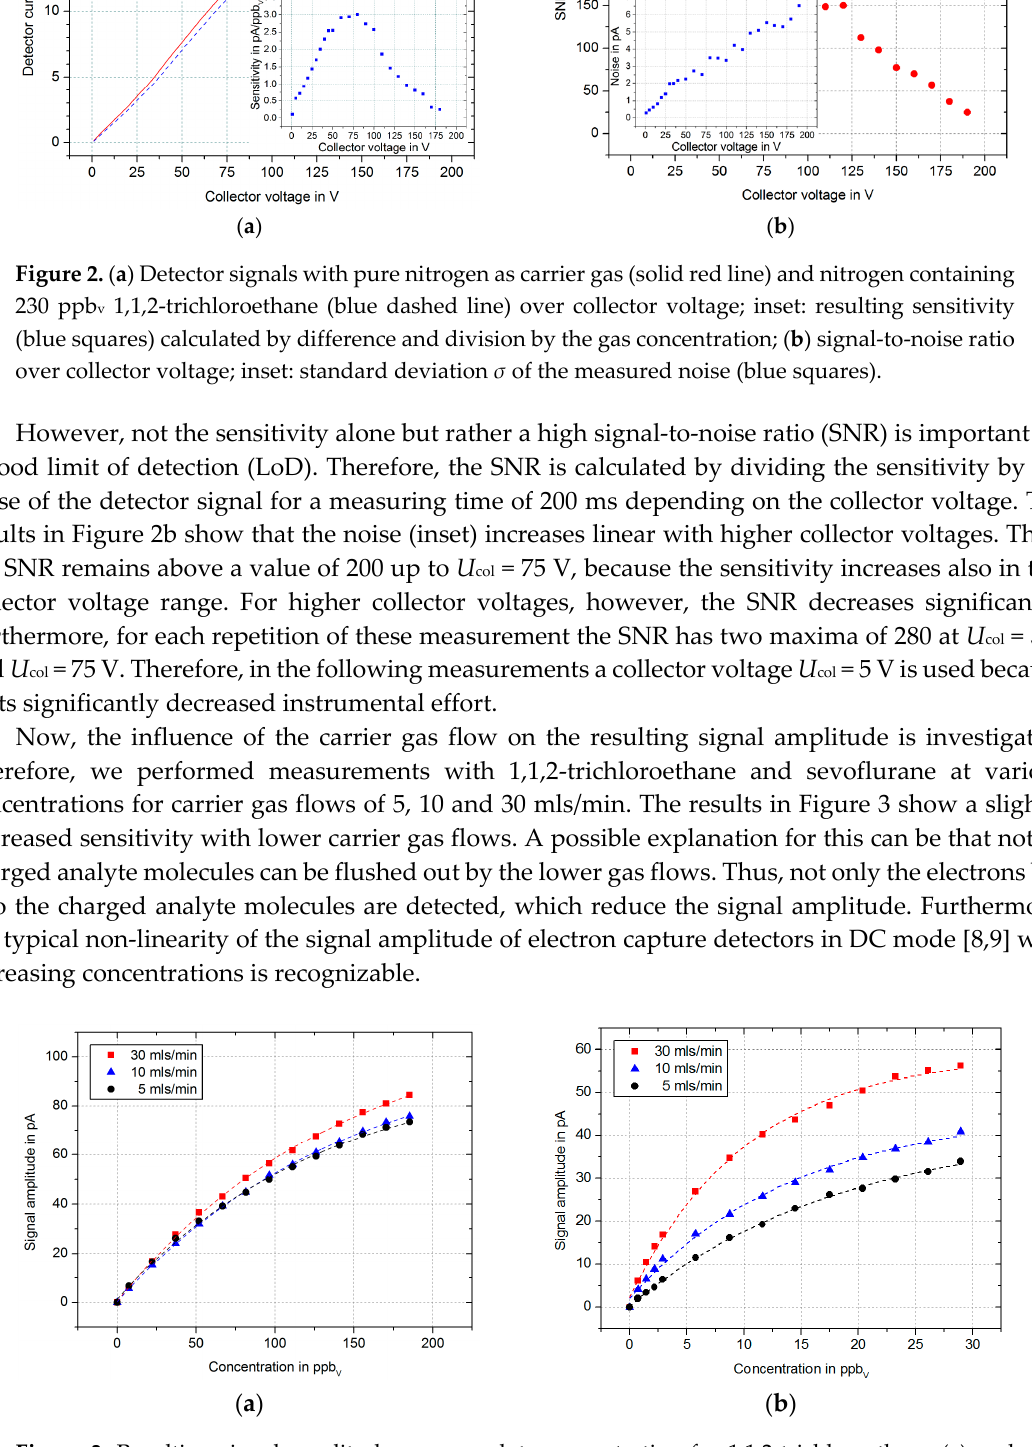
Figure 3. Resulting signal amplitudes over analyte concentration for 1,1,2-trichloroethane ( a ) and sevoflurane ( b ) for carrier gas flows of 5, 10 and 30 mls/min. ( a ) 1,1,2-trichloroethane; ( b )